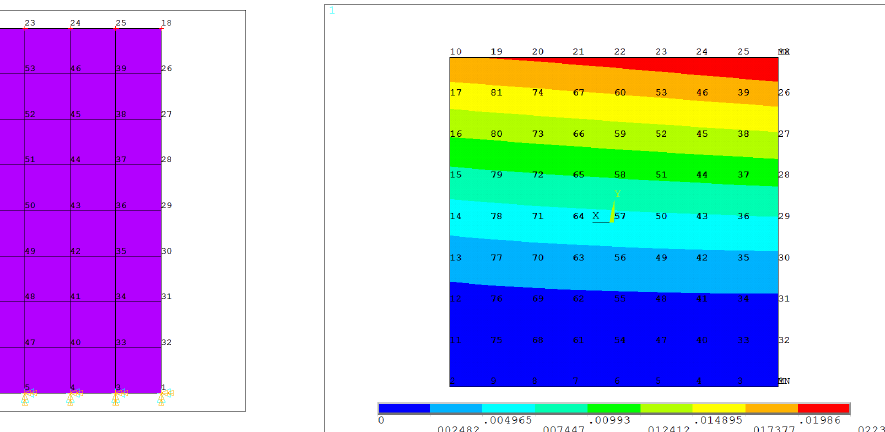
Figure 1: FRP laminated composite plate and node number (Element type: SHELL181).